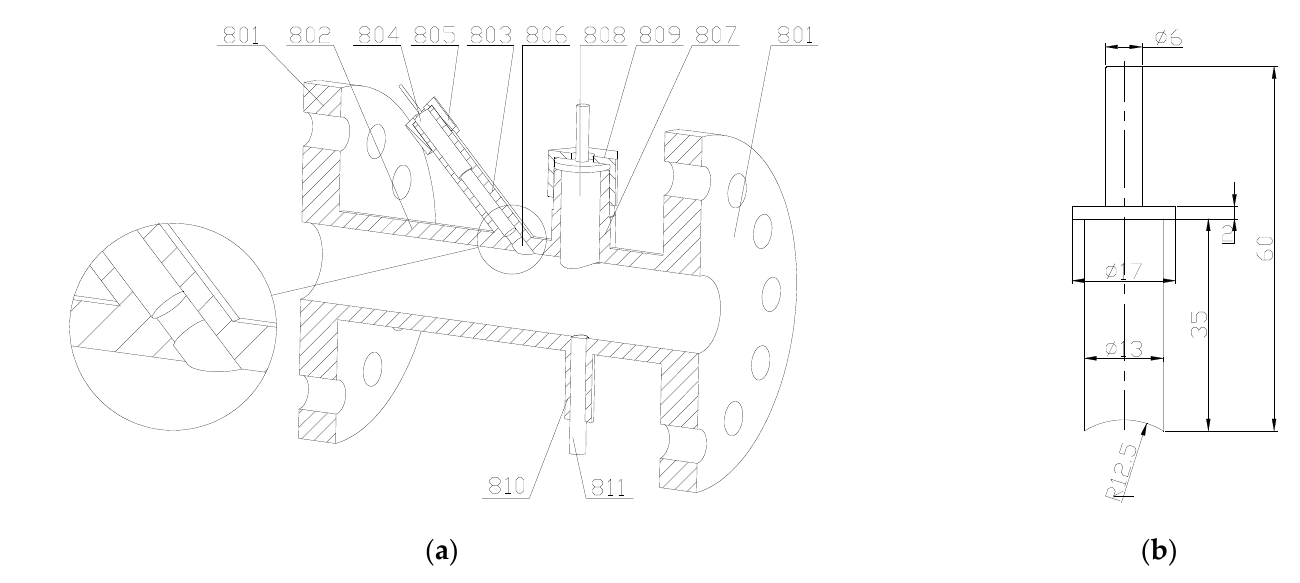
Figure 2. Schematic diagram of (( a ): 801—flange, 802—acrylic tube, 803—reference electrode in- stalling pipe, 804—reference electrode, 805—nut of the reference electrode, 806—porous material, 807—working electrode installing pipe, 808—working electrode, 809—nut of the working electrode, 810—auxiliary electrode installing pipe, 811—auxiliary electrode) the pipe-flow testing section and ( b ) the working electrode (mm).